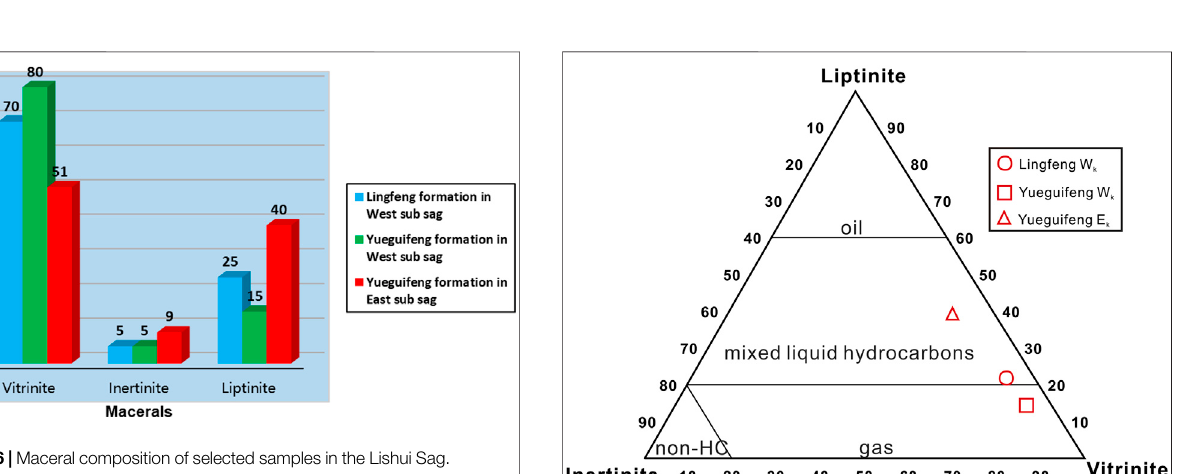
FIGURE 5 | Distribution of activation energy for hydrocarbon generation of methane and oil components AAC: average activation energy.